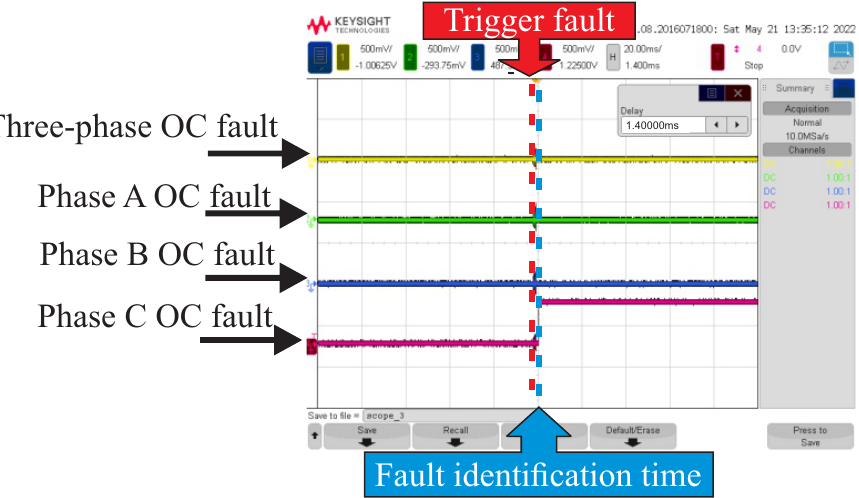
Figure 20. Single-phase open circuit fault identification with 4 × 4 SOM: Phase C; detection time 1.4 ms.